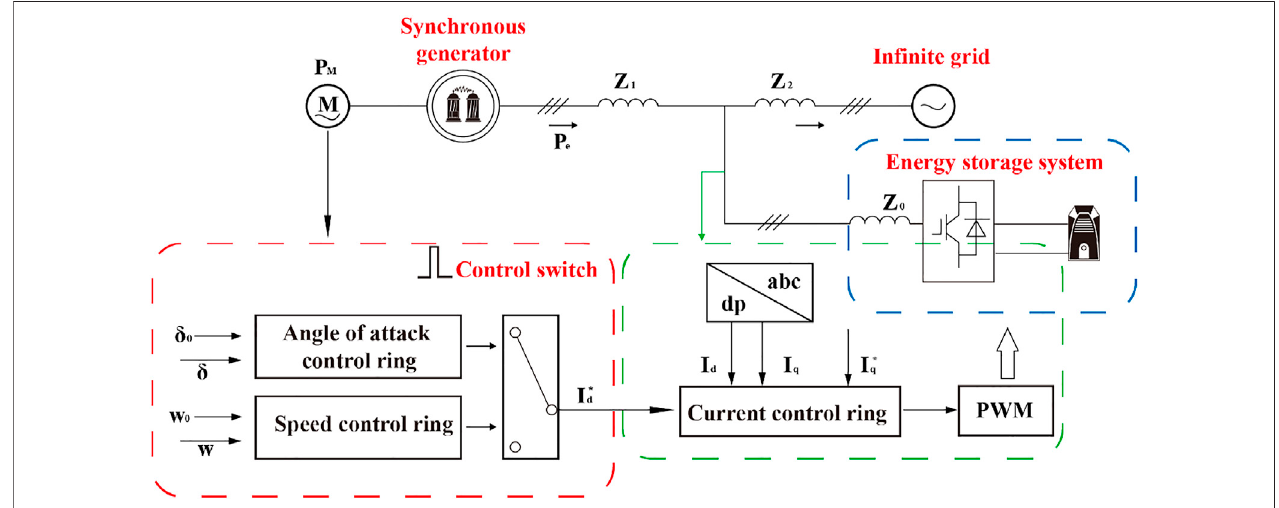
FIGURE 1 | Physical model of power